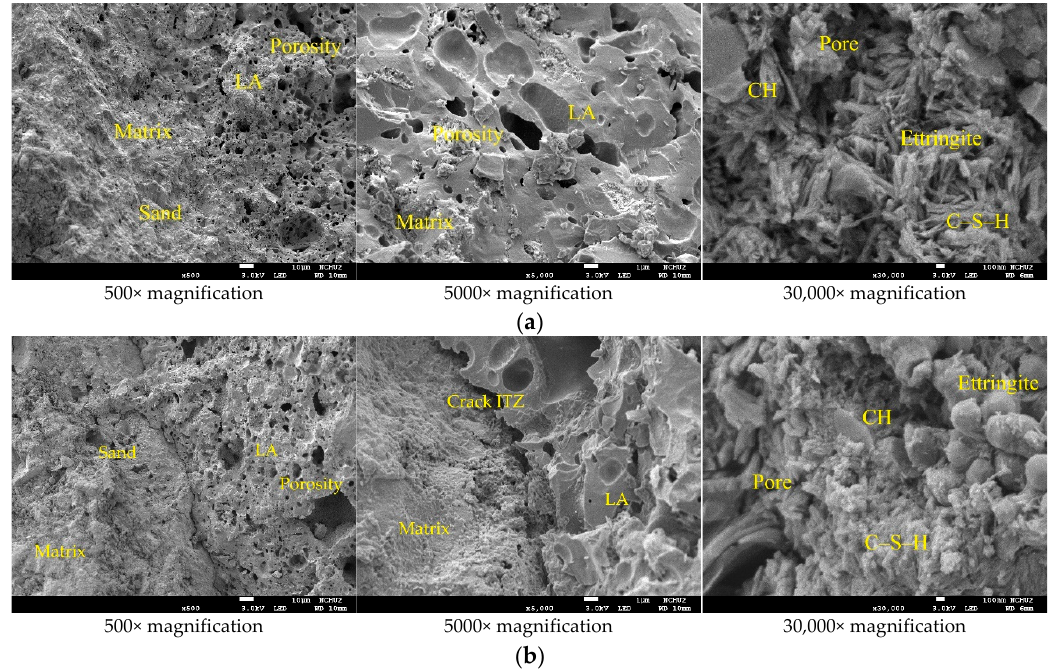
Figure 11. SEM micrographs of the concrete specimens after self-healing for 14 days: ( a ) control group; ( b ) experimental group.